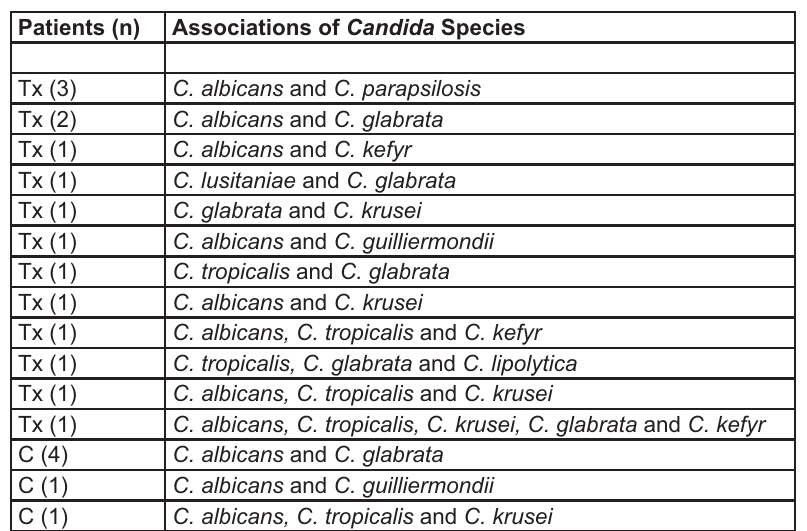
Figure 1- Associations of Candida species isolated from the oral cavity of orthotopic heart transplant patients (Tx) and control individuals